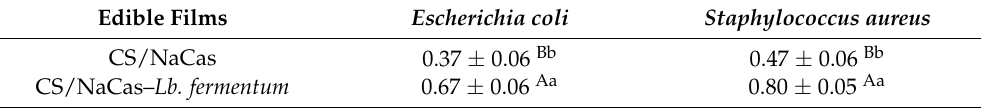
Table 7. Antibacterial activity of composite edible films with or without Lb. fermentum . Edible